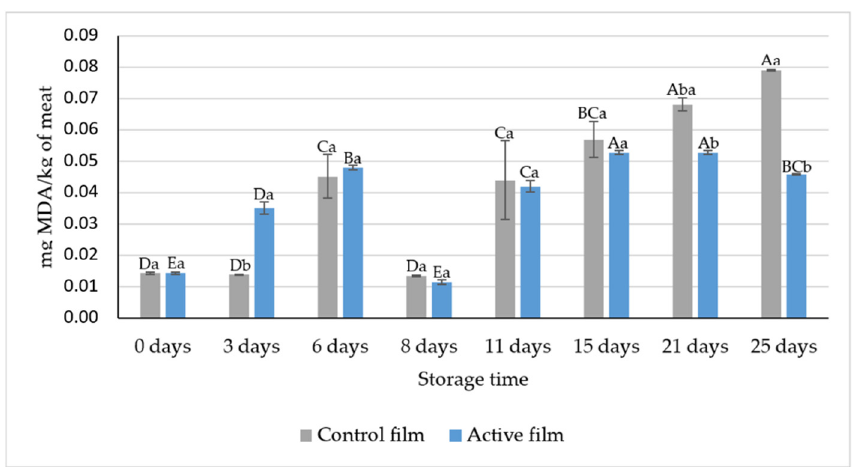
Figure 2. Results of the TBARS assay of the chicken breasts packaged for 25 days with the control and the active films. The results are expressed in mg of malonaldehyde equivalents per kg of meat, as means ± standard deviation of the replicants. ( A – E ): Within each treatment, values not sharing upper case superscript letters indicate statistically significant differences among days ( p < 0.05); ( a – b ): Within each storage day, values not sharing lower case superscript letters indicate statistically significant differences among treatment ( p < 0.05).